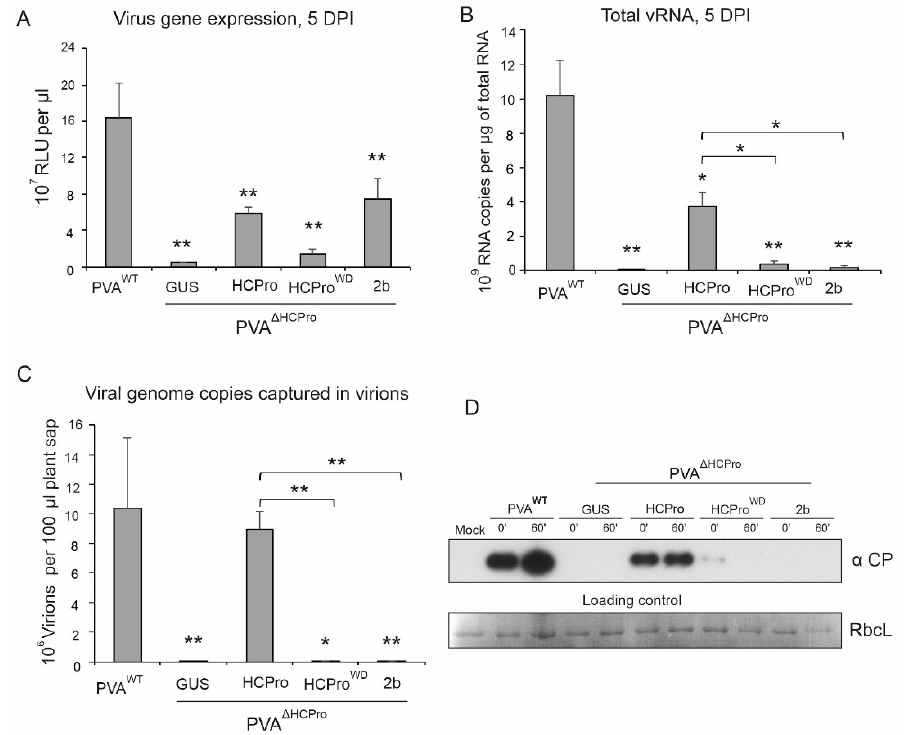
Figure 3. Transiently expressed HCPro complements gene expression and virion formation of HCPro-less PVA. ( A ) The RLUC activity was measured from PVA ∆ HCPro co-expressed with the GUS control, HCPro, HCPro WD or cucumoviral suppressor of RNA silencing, 2b. ( B ) Total RNA of PVA ∆ HCPro in the same experiment as in ( A ). ( C ) Quantitation of PVA ∆ HCPro RNA by RT-qPCR of immuno-captured templates in the same experiment as in ( A ). All the samples in ( A – C ) were collected at 5 dpi. RLUC, total RNA and particle-associated RNA levels from PVA WT infected plants is shown for comparison. ( D ) Samples from this experiment were subjected to in vitro degradation assay. A western blot analysis with anti-CP antibodies of the samples as they were at 0 min time point and after 60 min incubation of the plant sap at room temperature. RbcL band in Ponceau S-stained membrane is given as a loading control. p < 0.05 = *; p < 0.01 = **.